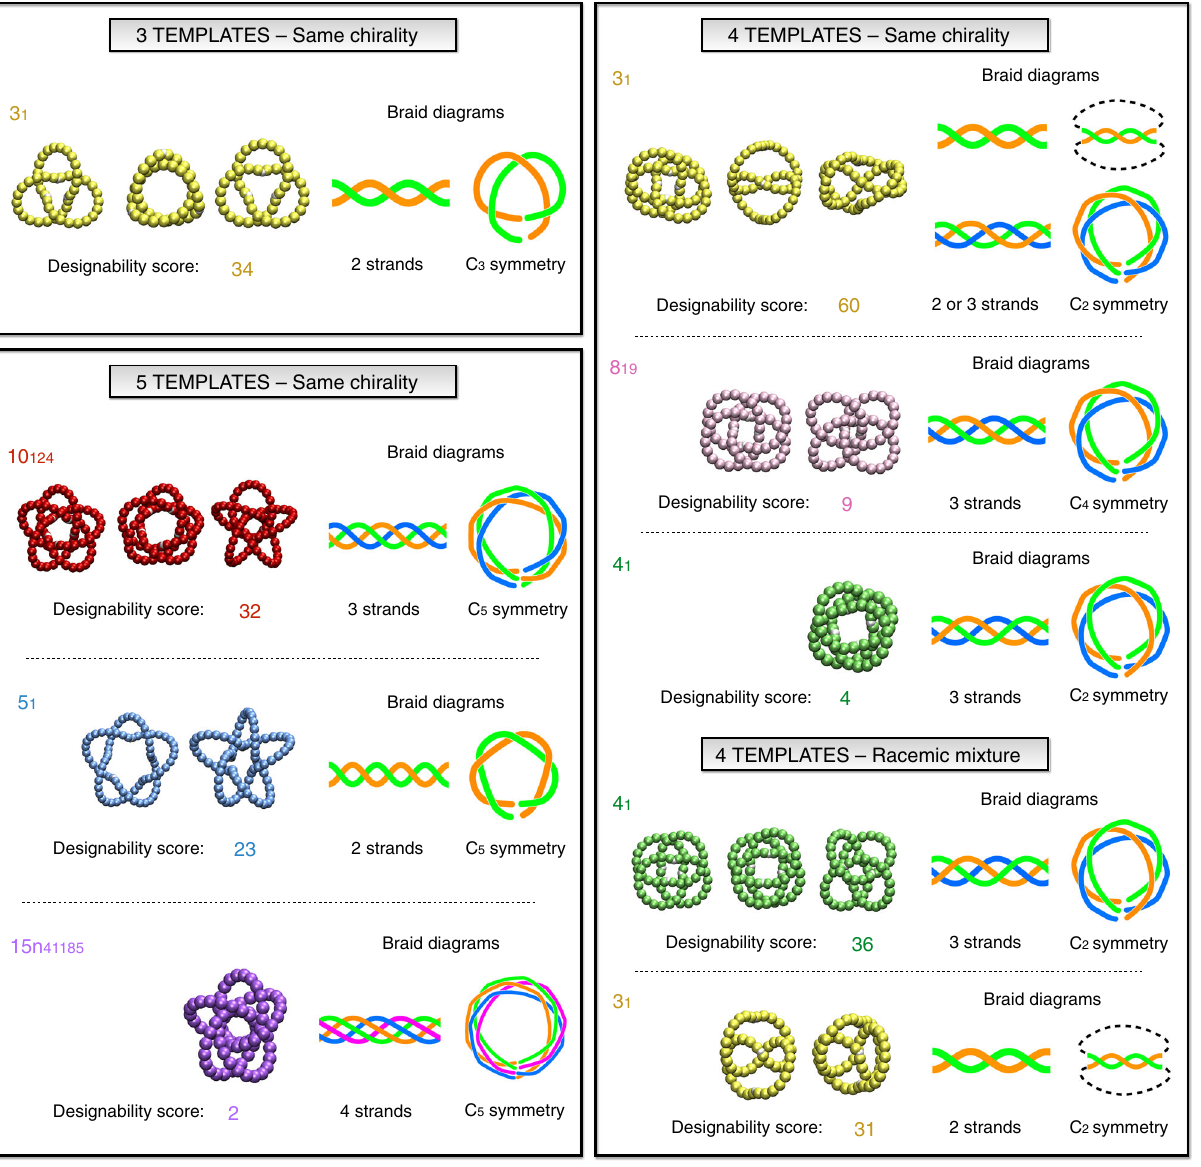
Fig. 2 Exhaustive repertoire of discovered privileged topologies. The graphical table provides the complete repertoire of non-trivial topologies that can be realised with up to fi ve identical helical templates (of same or opposite chirality) in the form of cyclic-simmetric and quasi-planar constructs. For each knot type we show one or more representative conformers (grouped by the number of templates) and the corresponding linear and braid representations. The designability score is the number of points in the discretised ( h , α ) parameter space of helical template shapes for which that knot type is